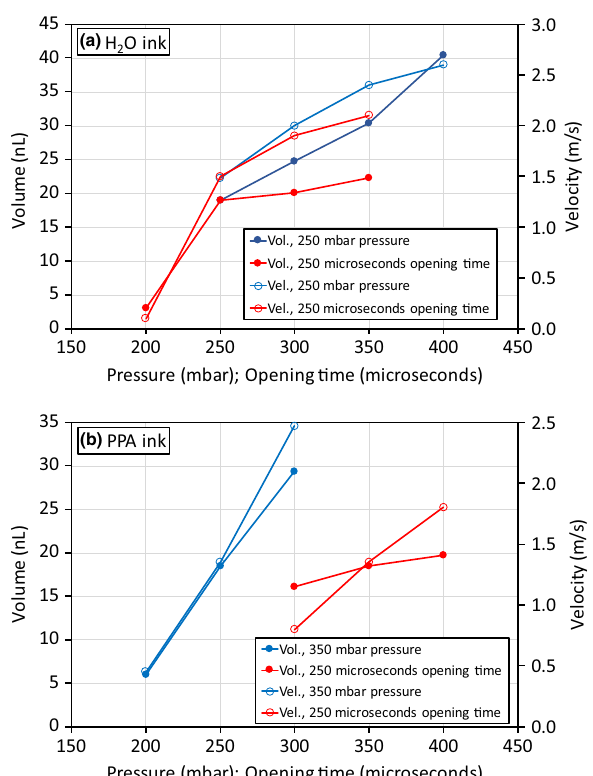
Fig. 2 Plots illustrating how the adjustable printing parameters affected the drop volume and velocity for ( a ) the water based ink and ( b ) the propionic acid based CGO ink. Series are plotted showing how both drop volume and velocity vary with opening time for a fixed pressure and vice versa. Higher pressures and longer opening times both give higher velocities and larger drop volumes